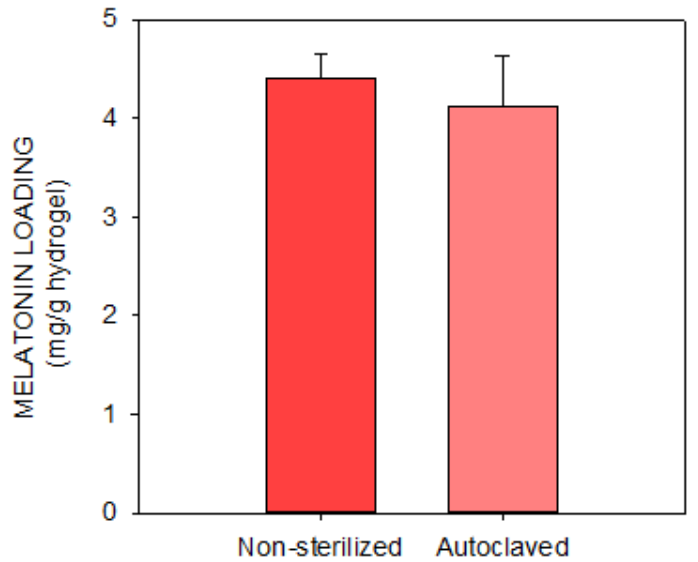
Figure 5. Amount of melatonin loaded by HEMA/APMA contact lenses when they were sterilized in drug solution by steam heat compared to non-sterilized contact lenses ( n = 3).